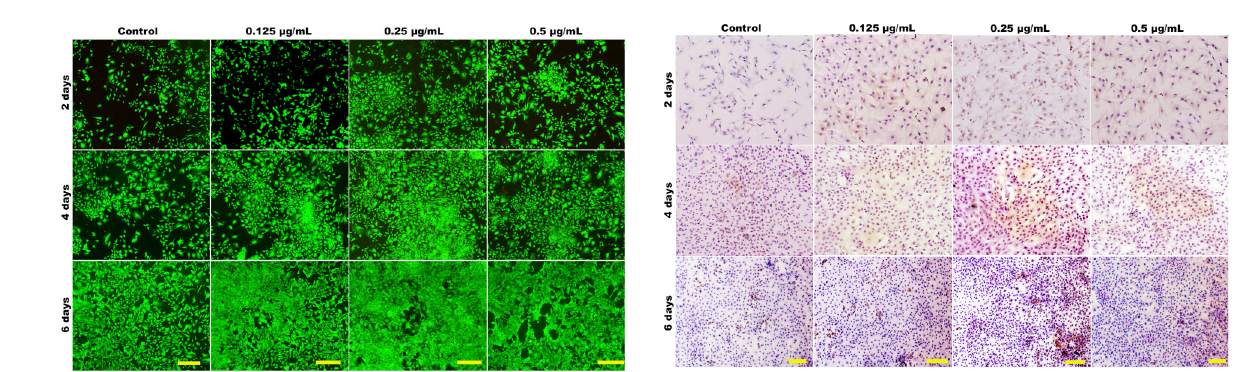
Figure 6. Laser-scanning confocal microscopy images showing the viability of chondrocytes cultured in vitro with 0 (control), 0.125, 0.25, and 0.5 mg/mL JJYMD-C for 2, 4, and 6 days. Scale bar: 100 mm.